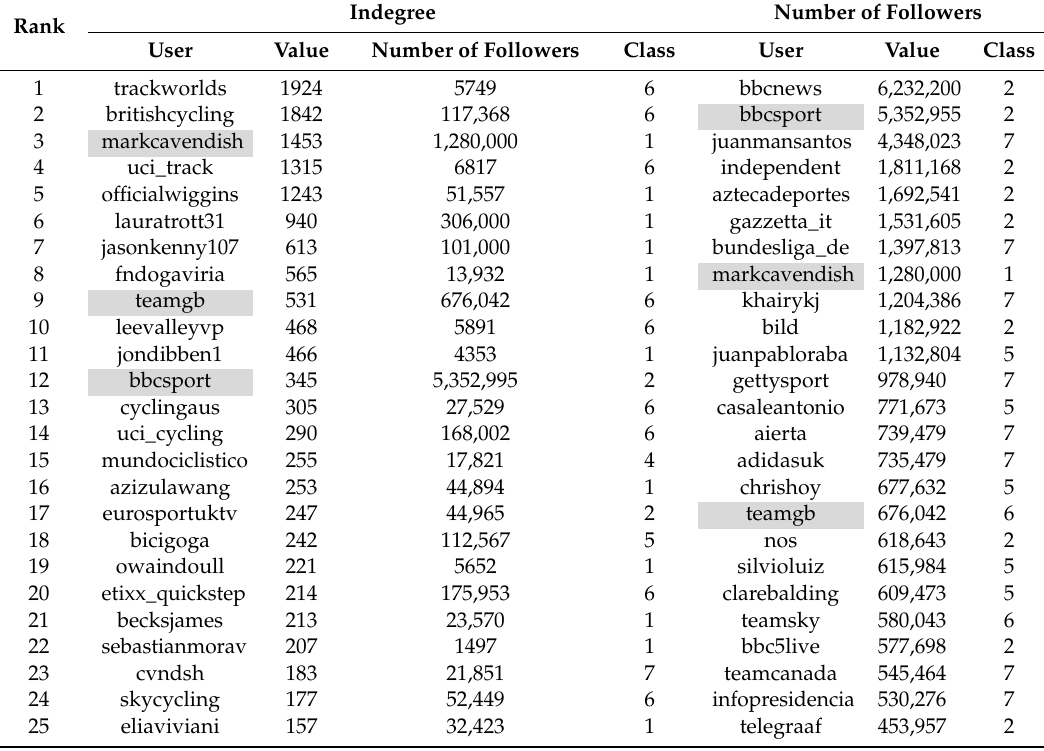
Table 3. Top 25 users by